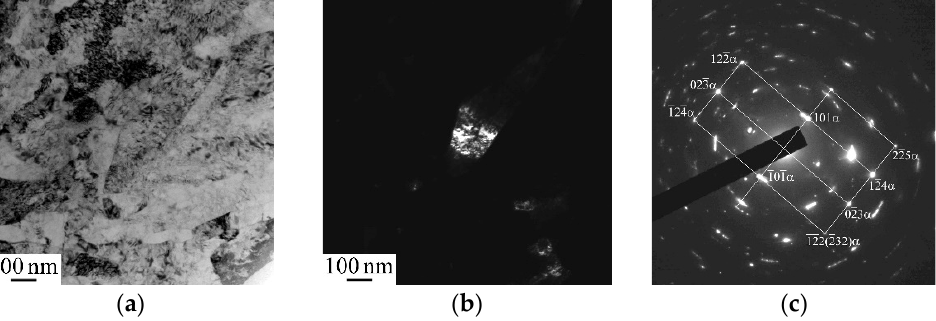
Figure 2. TEM bright- ( a ) and dark-field ( b ) images and associated selected area electron diffraction (SAED) patterns ( c ) of the microstructure of the uppermost surface layer of the CP-Ti sample after the UIT processing. TEM dark-field images were obtained with the 101(2(cid:3364)32) α -Ti reflection.